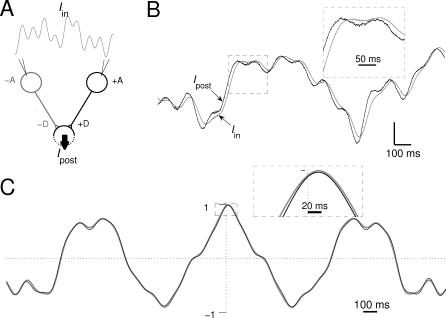
Anticipatory Responses through a Taylor-Approximation–Inspired Neurophysiological Circuit(A) Model scheme for a biological implementation of the first-order Taylor approximation.(B) Anticipatory I
post response to I
in = I
signal of Figure 4 (both currents equally smoothed for readability). Dashed square zoomed in inset. Vertical scale bar represents 0.5 μA/cm2.(C) Cross-correlation function between I
post and I
in (black) superimposed on autocorrelation function of I
in displaced by 16 ms (gray). Inset shows the displacement of the central peak (dashed square).